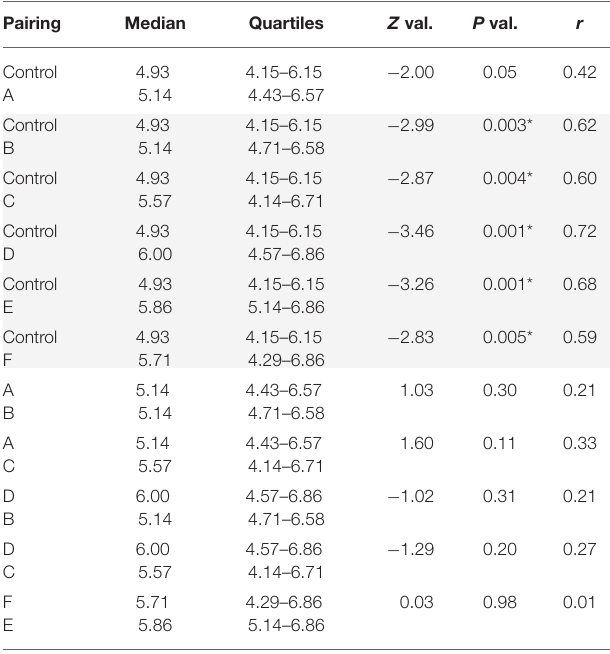
TABLE 3 | Wilcoxon signed-rank test—largest distance away from attractor.